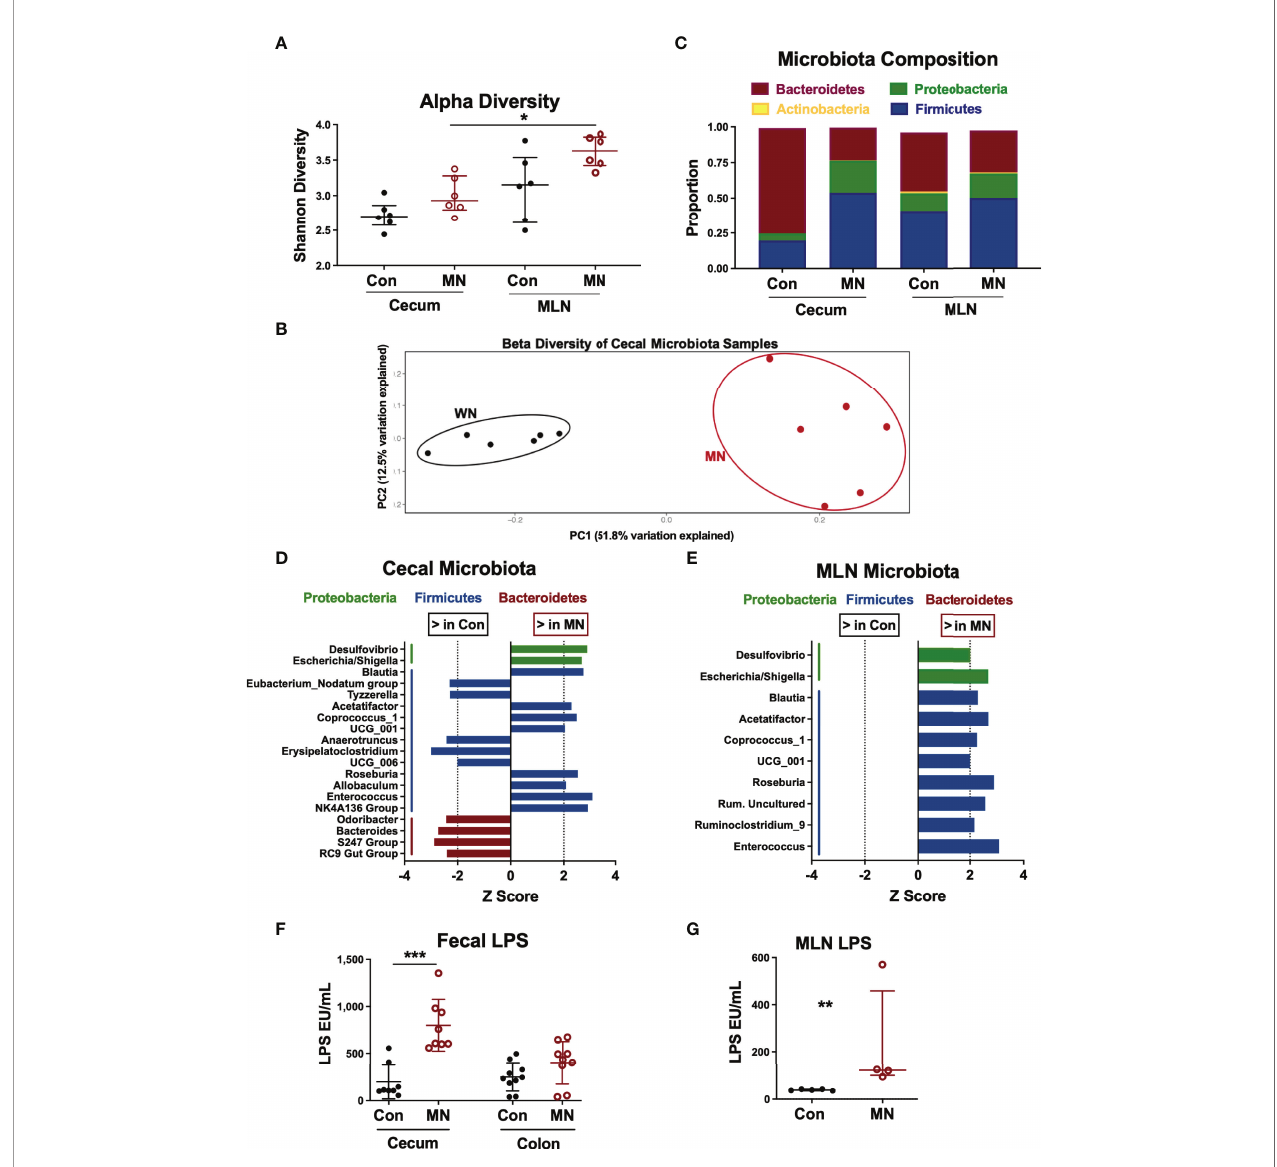
FIGURE 5 | Malnutrition increases proportions of Proteobacteria and Firmicutes and bioactive LPS in cecum and mesenteric lymph node. Microbiota composition determined by bacterial 16S rRNA sequencing of cecal contents and MLN samples from 5 control (Con) and 5 malnourished (MN) mice. (A) Alpha diversity for control and MN cecal stool and MLN samples. (B) Beta diversity for control and MN cecal content microbiota. (C) Average proportions of four most common phyla in cecal stool and MLN samples. (D, E) Signi fi cant (p < 0.05, Wilcoxon signed-rank test) genus-level differences in microbiota of the cecum (D) and MLN (E) between control and MN mice. Z score indicates level of variance in proportion between Con and MN mice (i.e. values further from 0 indicate greater difference between groups). (F) Total bioactive fecal LPS in contents of cecum and colon of control and MN mice. Determined by HEK-blue TLR4 bioassay. (G) Concentration of bioactive LPS in MLN draining the proximal large intestine of control and MN mice. Determined by HEK-blue TLR4 bioassay. Data are presented as the median with interquartile range. (*p < 0.05; **p < 0.01; ***p <